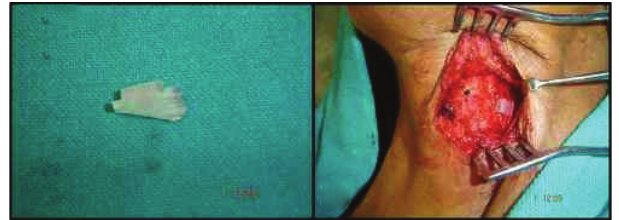
Figure 1 A, Carved-out type B silastic implant. B, Silastic implant placed in cartilage window.